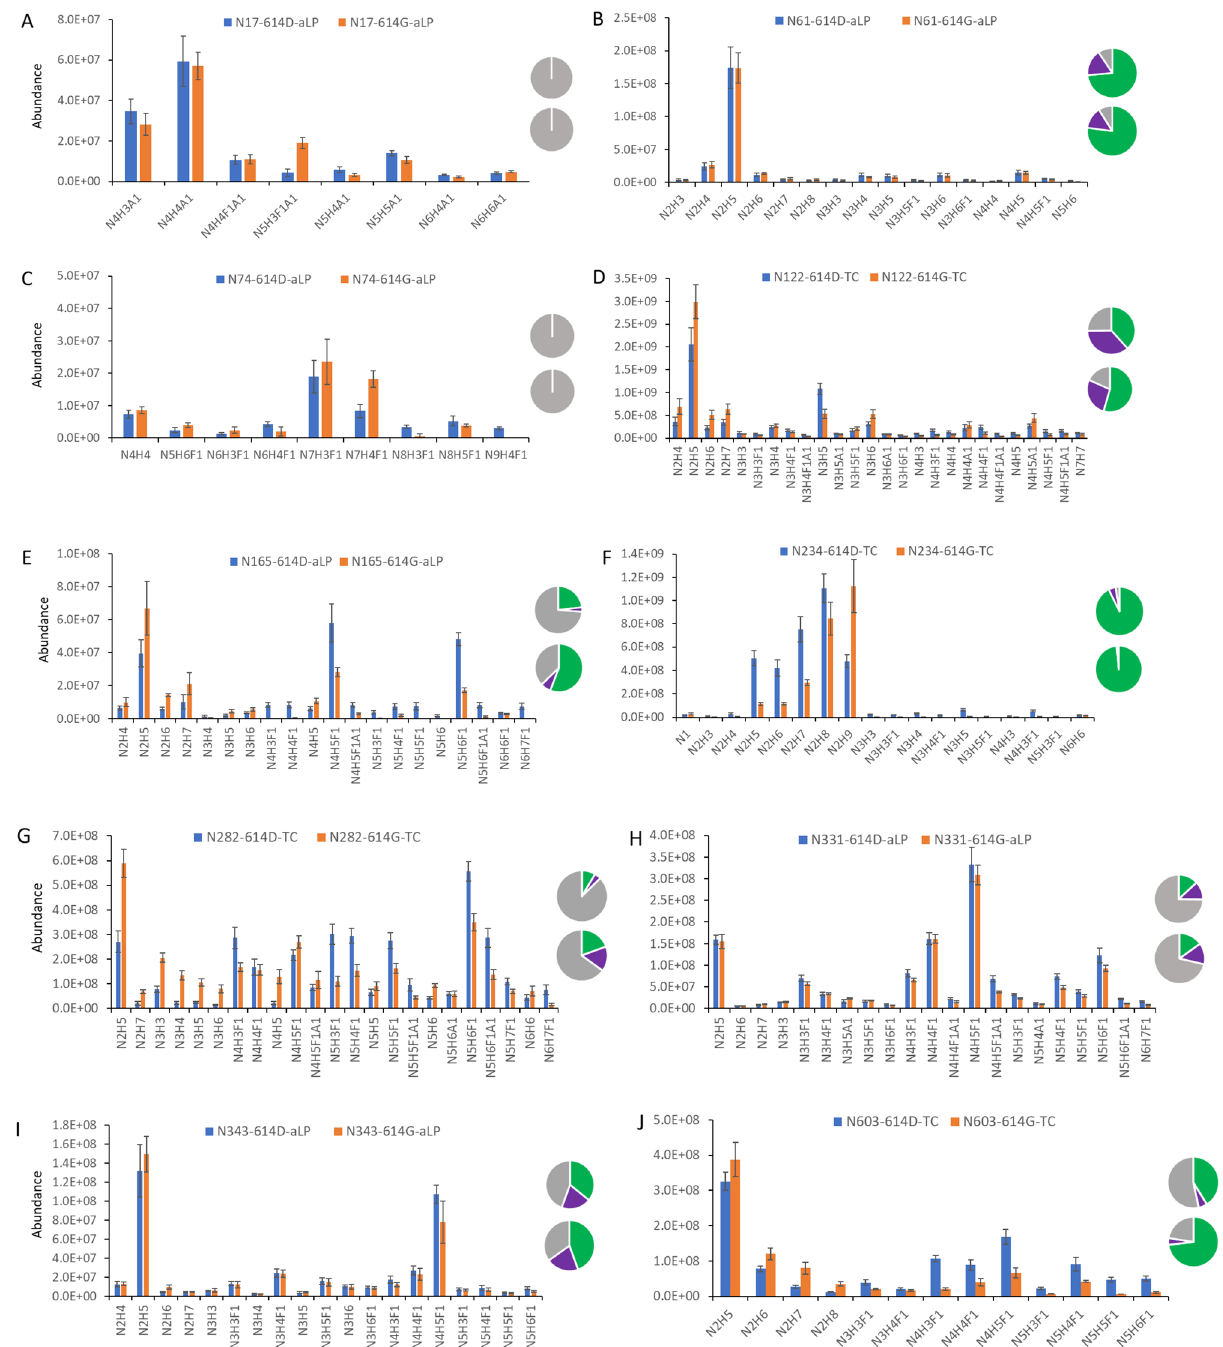
Figure 2. Comparison of N-linked glycosylation profiles in ectodomain spike protein between S-614D (blue) and S-614G (orange) samples. Glycosylation abundances were calculated from one representative native peptide sequence for glycan sites ( A ) N17, ( B ) N61, ( C ) N74, ( D ) N122, ( E ) N165, ( F ) N234, ( G ) N282, ( H ) N331, ( I ) N343, ( J ) N603, ( K ) N616, ( L ) N657, ( M ) N709, ( N ) N717, ( O ) N801, ( P ) N1074, ( Q ) N1098, ( R ) N1134, ( S ) N1158, and ( T ) N1173. Inserted pie charts (upper: 614D; lower: 614G) depict the relative composition of high- mannose (green), hybrid (purple), and complex (gray) types of glycoforms. In the short names of individual glycans, N, H, A, and F symbolize HexNAc, Hex, NeuAc, and Fuc, respectively. X-axis represent individual